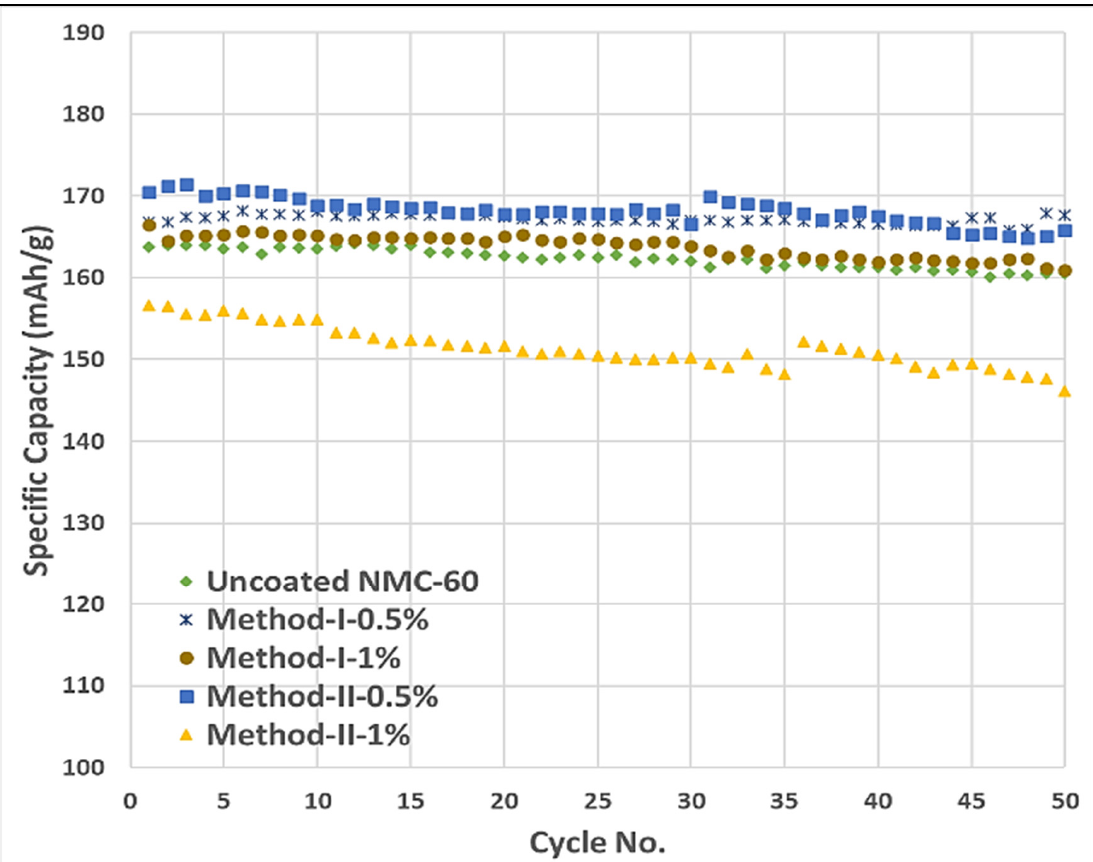
Figure 9. Cycling performance of the uncoated NMC-60 and 0.5 wt.% and 1 wt.% LNO coating NMC-60 using Method-I and Method-II.